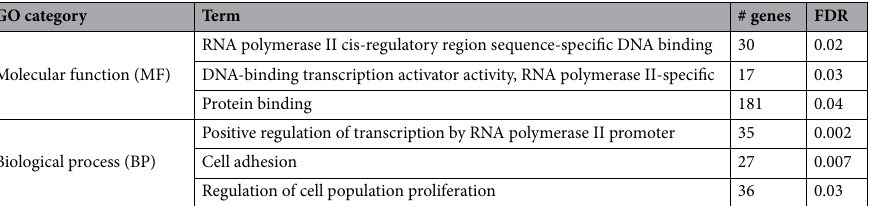
Table 3. Functional annotation analysis of differentially methylated genes associated with vitamin D supplements and high physical activity group. * # genes: Number of genes, FDR False discovery